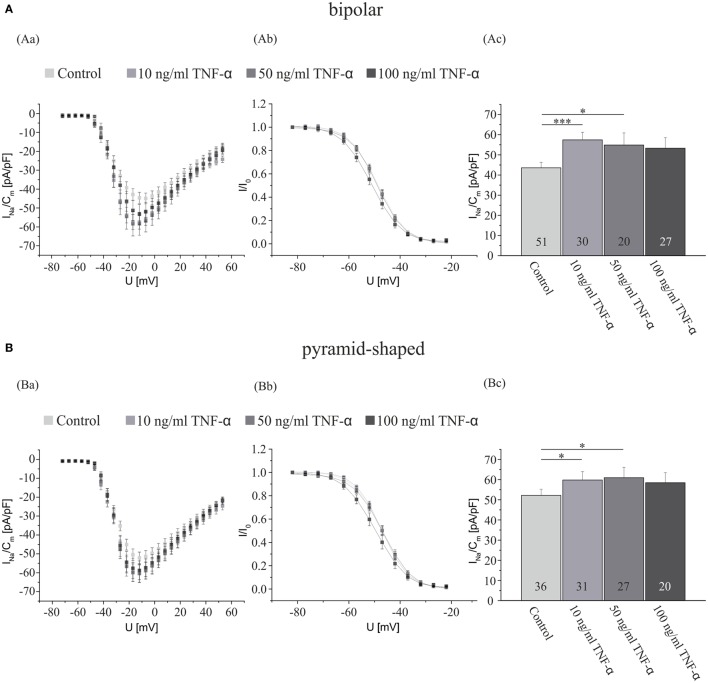
TNF-α exposure for 4 days increases the Na+ current density of cultured hippocampal neurons. Analysis of the whole data set for (A) bipolar and (B) pyramid-shaped cells. (Aa,Ba) Average current–voltage relationships for Na+ currents normalized to capacitance recorded from neurons cultured in the presence or absence of 10, 50, or 100 ng/ml TNF-α for 4 days. (Ab,Bb) Influence of a preincubation with TNF-α on steady-state inactivation of Na+ currents. Solid lines represent fits to the modified Boltzman equation as detailed in Section “Materials and Methods.” (Ac,Bc) Peak Na+ current densities of neurons cultured in the presence or absence of 10, 50, or 100 ng/ml TNF-α for 4 days determined at test potentials of −12 mV starting from holding potentials of −77 mV. Note that maximal Na+ current densities are already measured at a concentration of 10 ng/ml of TNF-α, suggesting that the receptors are already saturated at this dosage. All recordings performed at day 7 in culture after incubations with test substances for 4 days following a preculture period of 3 days. Numbers in bar charts indicate numbers of cells recorded from. Database for every column derived from 4 to 10 different preparations. Error bars represent means ± SE, *p < 0.05, **p < 0.01, and ***p < 0.005.